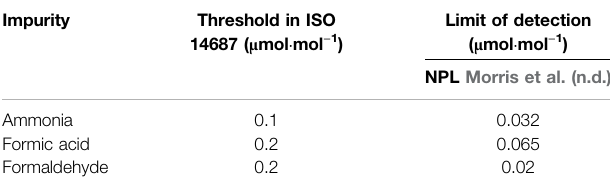
TABLE 9 | Detection limit per impurity with SIFT-MS for